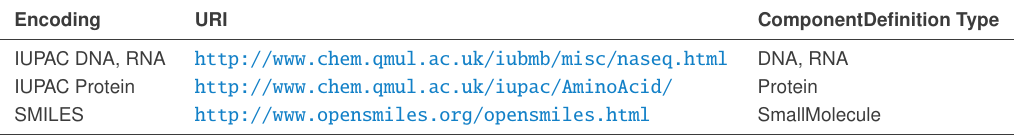
Table 1: URI s for specifying the encoding property of a Sequence , organized by the type of ComponentDefinition (see Table 2) that typically refer to a Sequence with such an encoding .